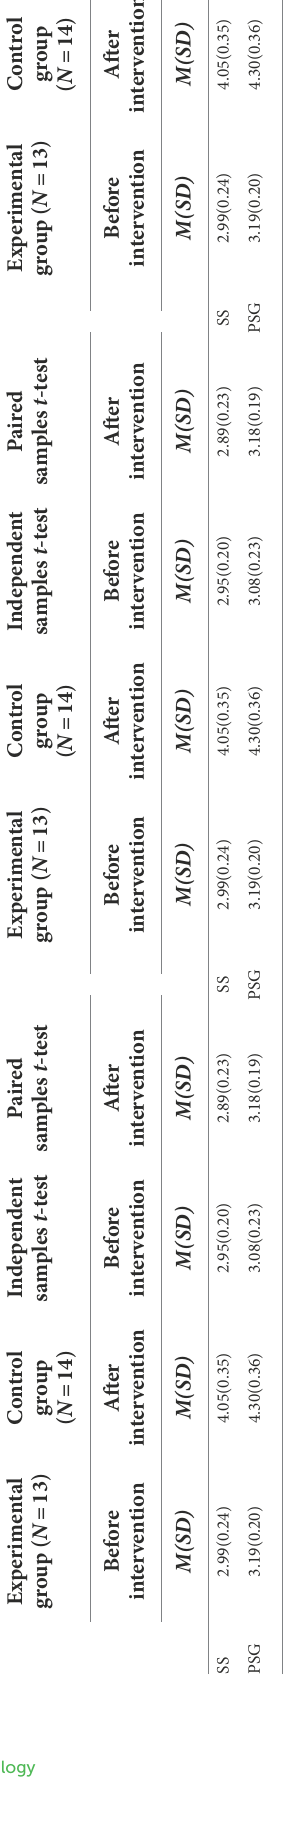
TABLE 3 Group psychological counseling effect feedback